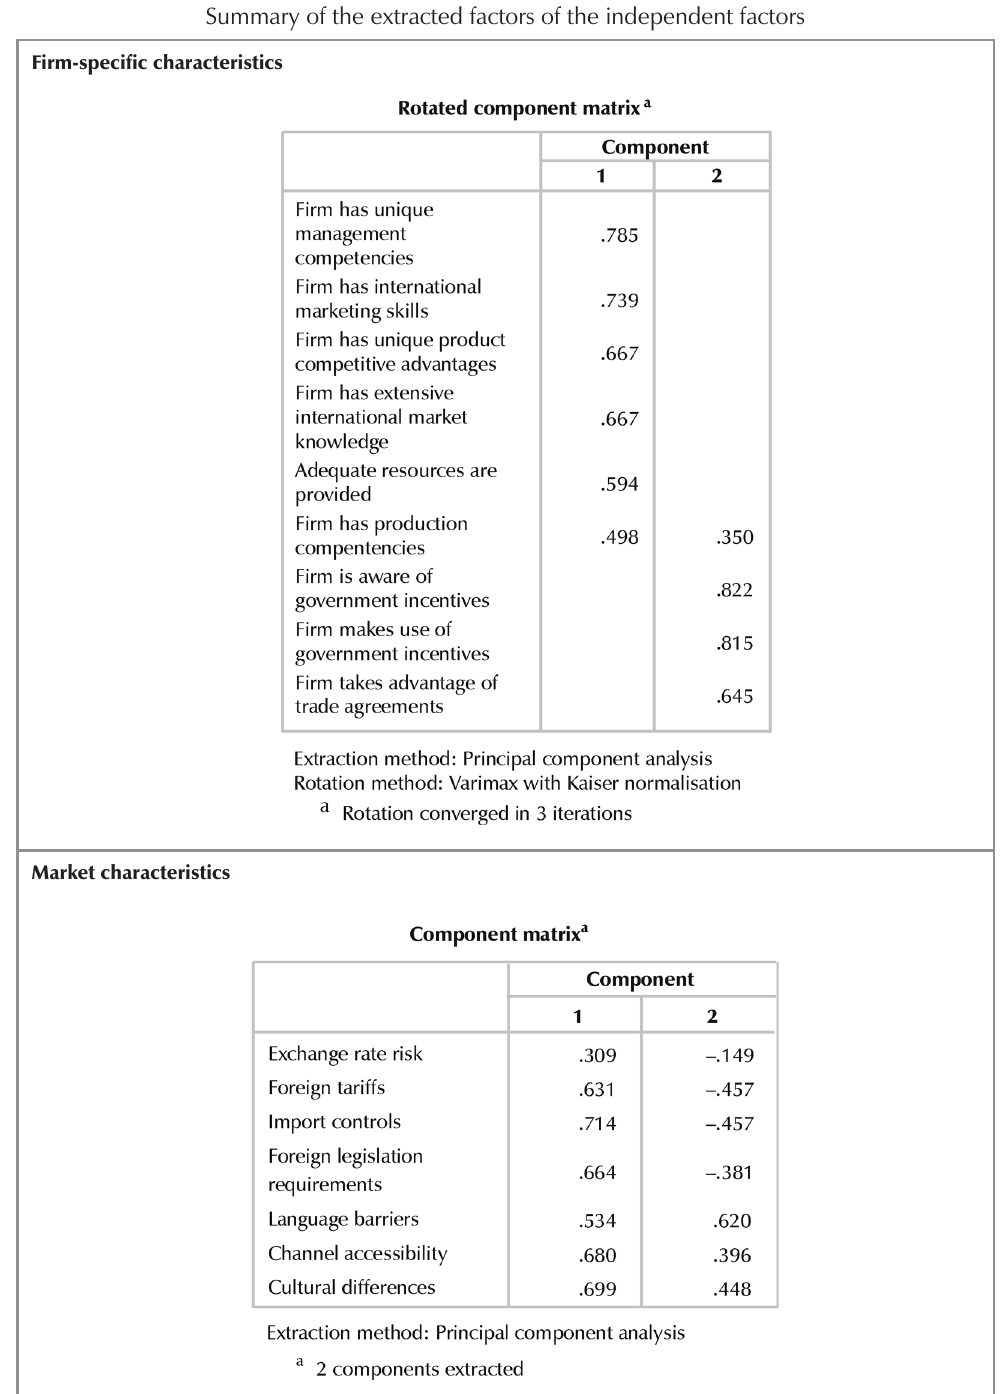
Summary of the extracted factors of the independent